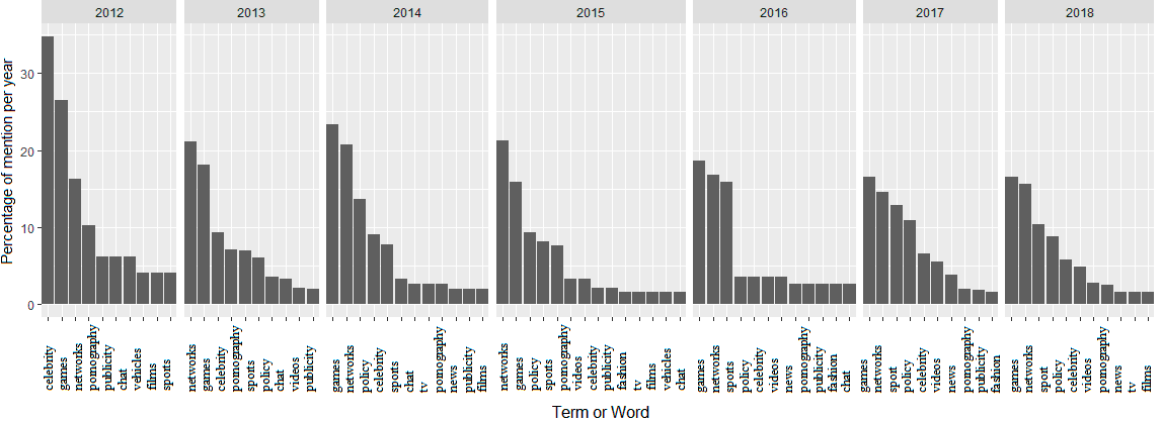
Figure 2. Frequency of mention of the word or related terms (per year) in response to the following question: What topics would not occupy your time in your use and consumption of the Internet?